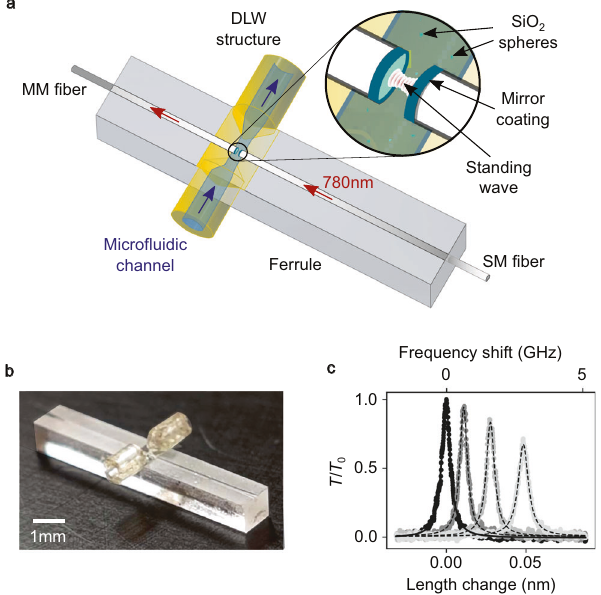
Fig. 1 Fabry-Pérot microcavity device and measurement signal. a Schematic setup showing the cavity and its integration into a glass ferrule with a direct-laser-written (DLW) structure (yellow) forming the micro fl uidic channel. The cavity consists of a single-mode (SM) and a multi-mode (MM) glass fi ber with dielectric mirrors attached to their end facets. b Photograph of the micro fl uidic device. c Examples of the cavity transmission signal T / T 0 for an empty cavity (black) and with nanoparticles present at increasing spatial overlap with the cavity mode (decreasing gray value). An increasing frequency shift, decreasing peak transmission, and increasing linewidth are